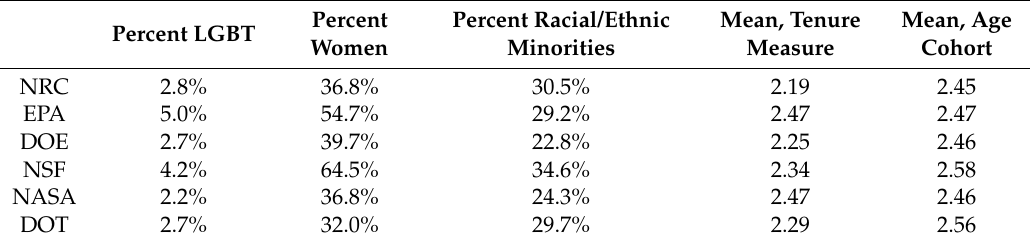
Table A1. Demographic Characteristics of STEM-Related Agencies (N =